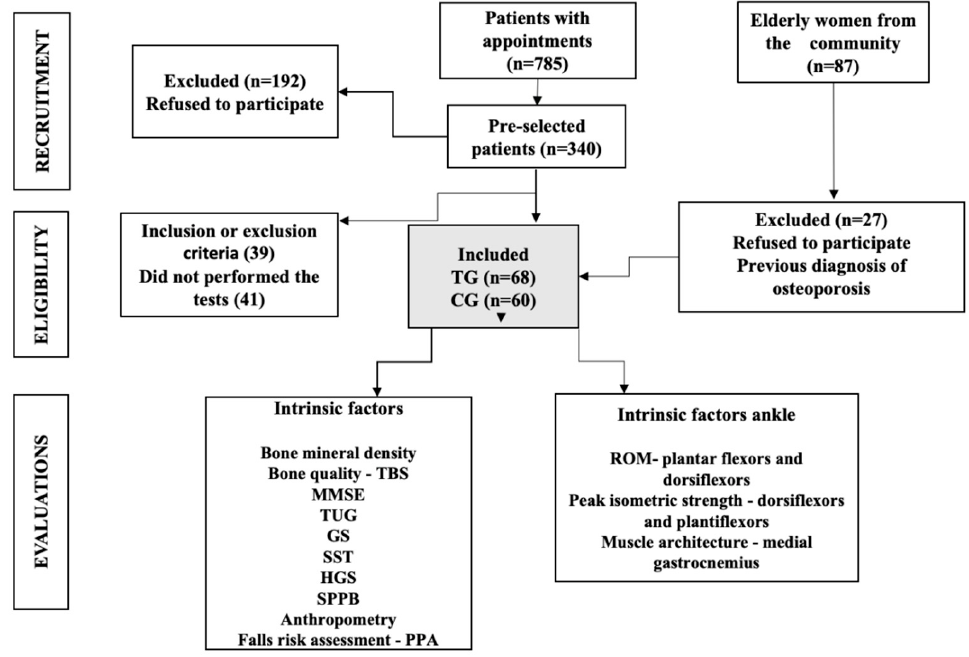
Figure 1. Flow diagram of the selection of the study participants. TG, treatment group; CG, control group; TBS, trabecular bone score; MMSE, mini-mental state examination; TUG, timed up and go test; GS, gait speed; SST, sit-to-stand test; HGS, hand-grip strength; SPPB, short physical profile battery; PPA, physiological profile assessment; ROM, range of motion.